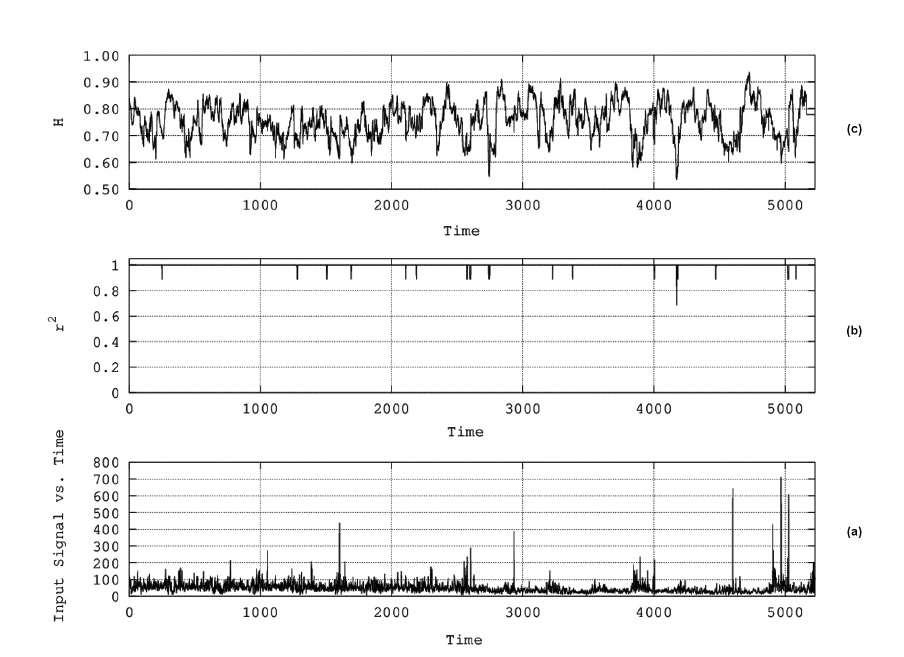
Figure 6. R/S analysis of the PM 10 time series recorded by the LYK station between the years 2001–2016. From bottom to top: ( a ) time series (mean daily values/concentrations). ( b ) Square of Spearman’s correlation coefficient. ( c ) Hurst exponent time series. PM 10 concentration in µ g/m 3 . Time is in days (or sample number). Each window of analysis contains 64 samples.